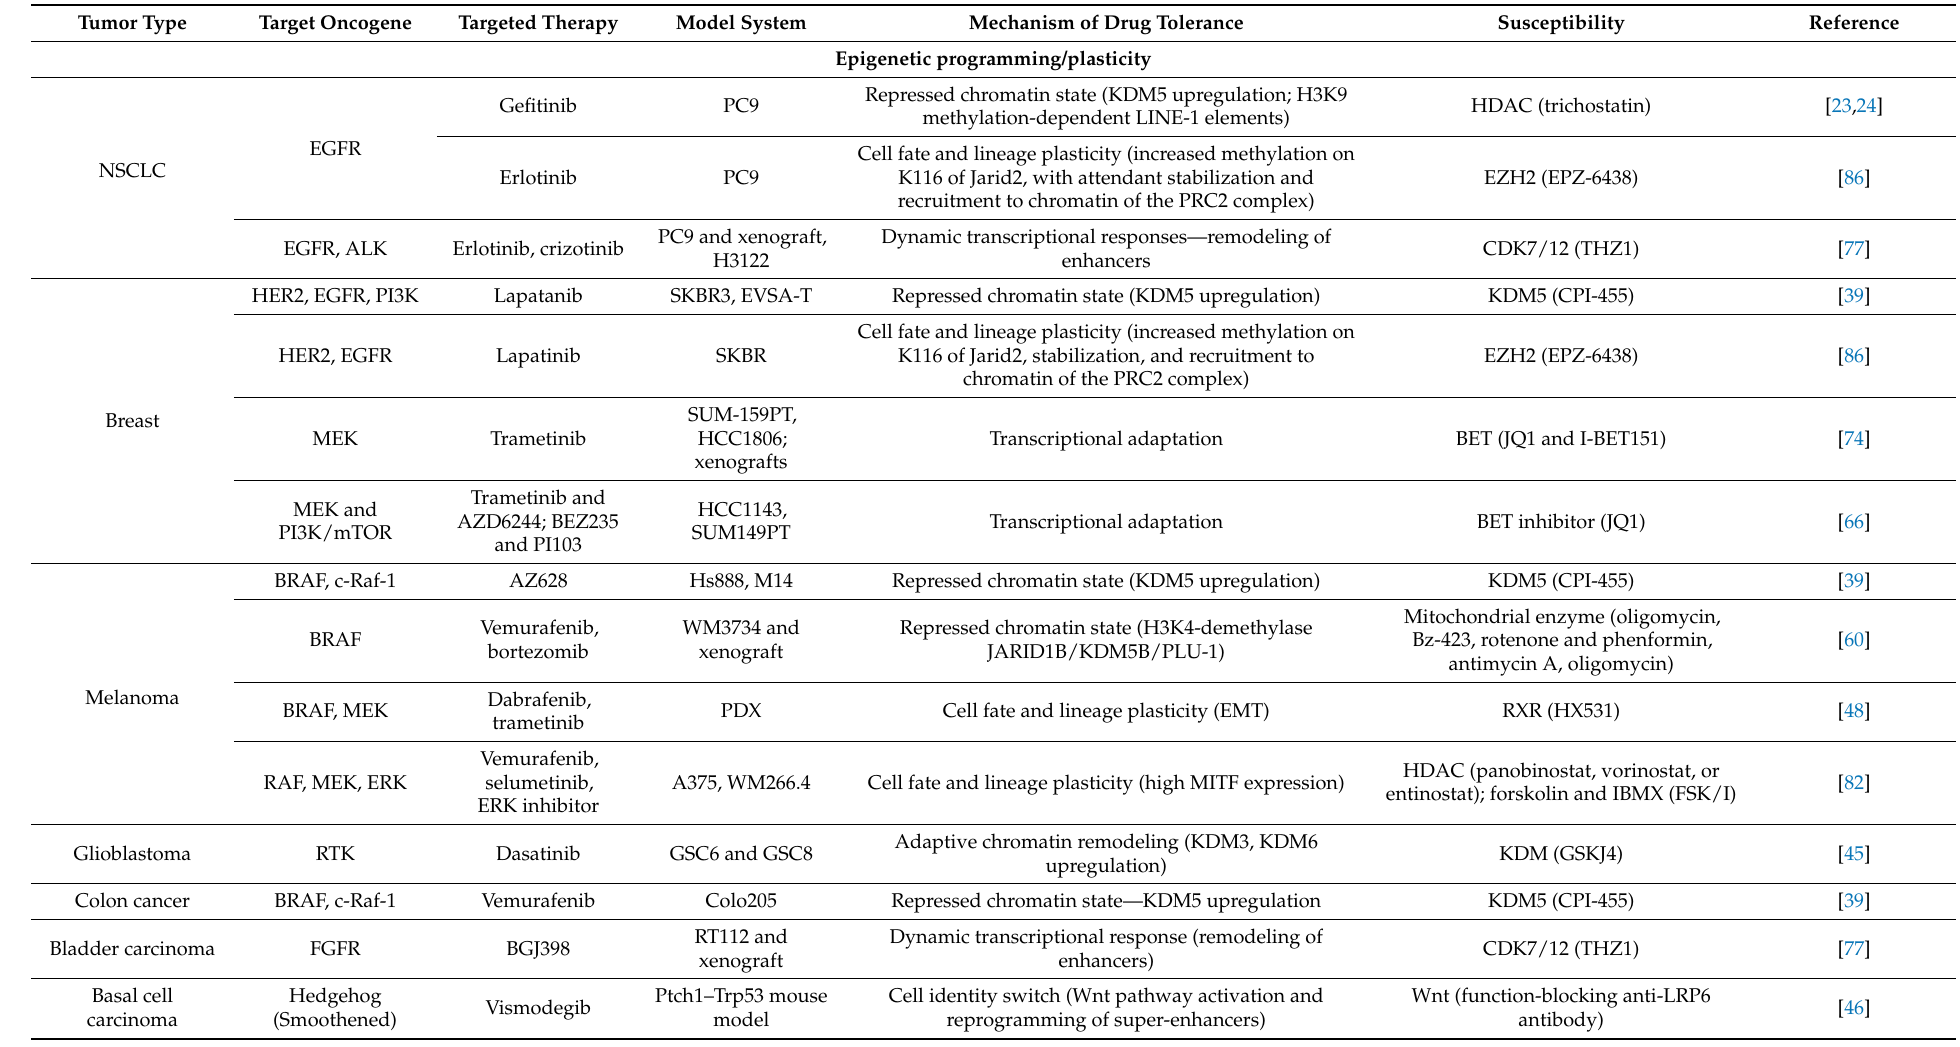
Table 1. Studies on drug-tolerant persister cells to elucidate mechanisms of persistence using in vitro and in vivo experimental cancer